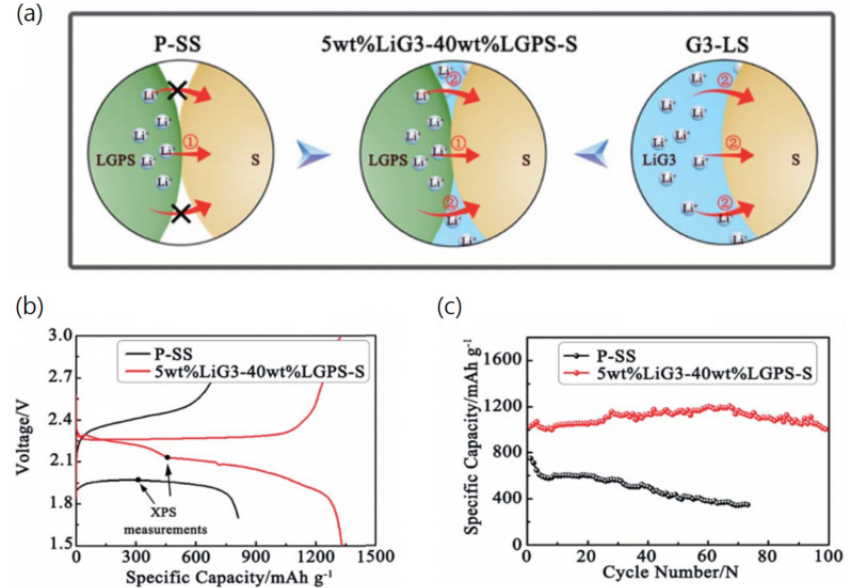
Figure 4. ( a ) Scheme of Li + pathways in different sulfur/electrolyte interphases of a Li-S battery; ( b ) charge–discharge curves of pristine composite cathode powder (P-SS), 5 wt% LIG 3 -40 wt% LGPS-S at 50 mA cm − 2 , ambient condition; ( c ) cyclic performances at 0.2 C. Reprinted 2019 from [80] with permission from the Royal Chemical Society.